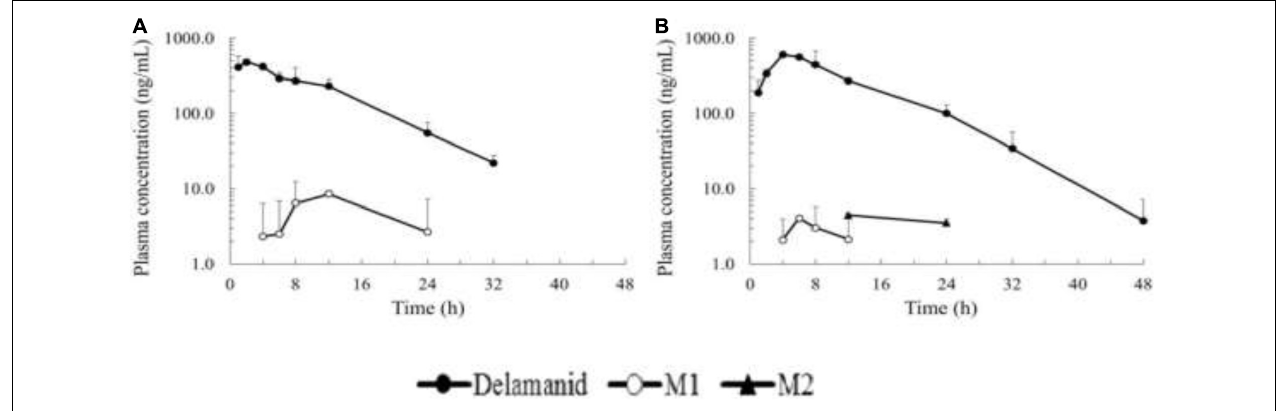
FIGURE 3 | Plasma concentration time profiles of delamanid single oral dose and M1/M2 metabolites in mice (A) and rats (B)